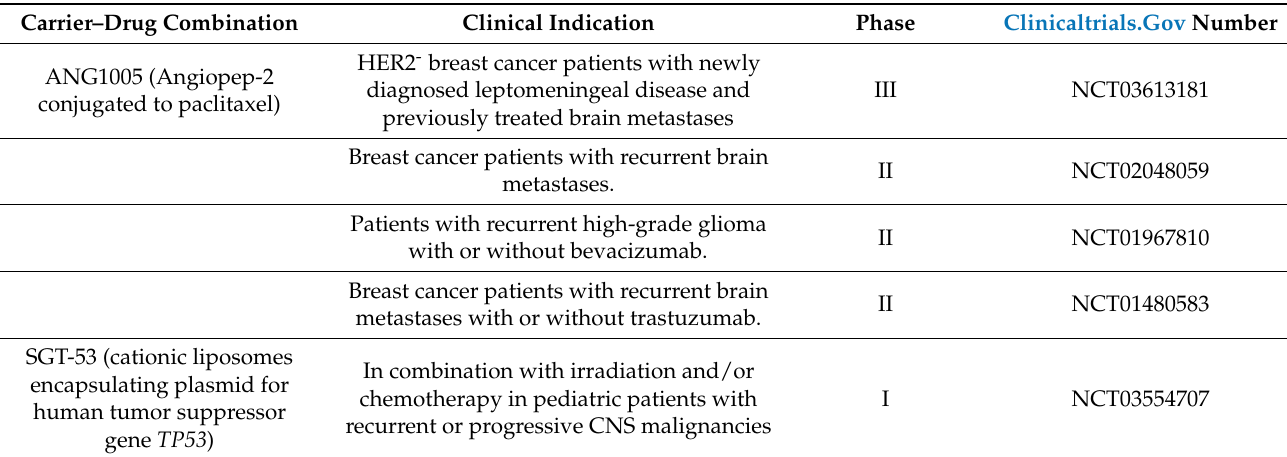
Table 3. Clinical trials based on approaches that exploit physiological transport mechanisms (RMT)